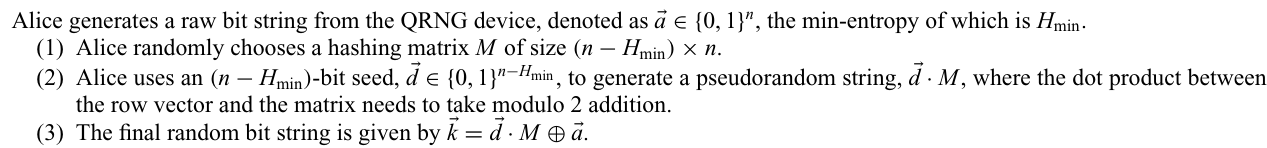
TABLE IV. Stream randomness